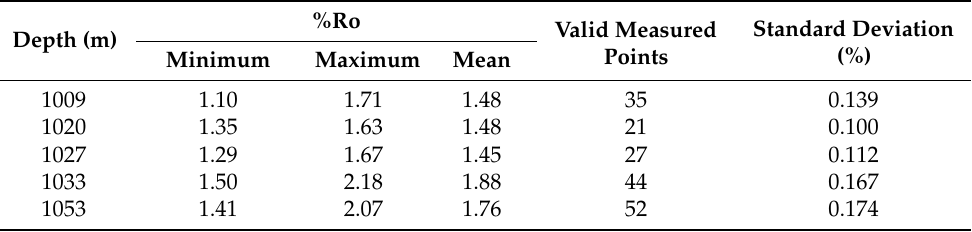
Table 3. Measured Ro values of source rock samples from well Chaiye 2.